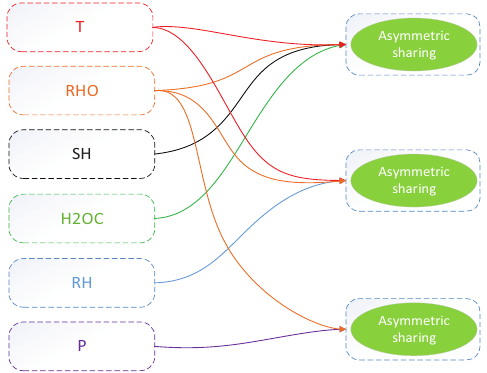
Figure 1. Schematic of the asymmetric shared layer